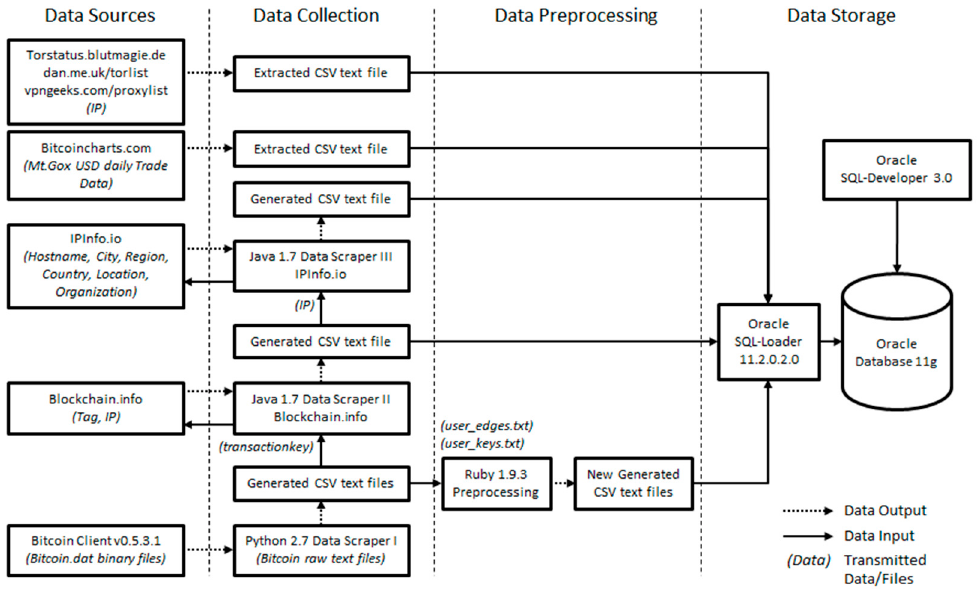
Figure 2. Data Flow Process.